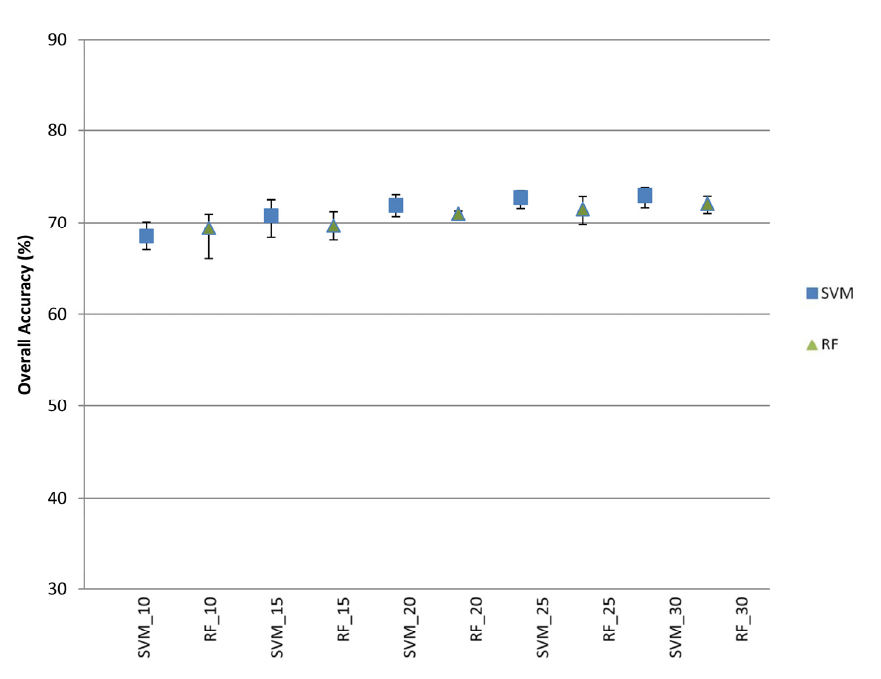
Figure 4. Overall accuracies of random forest (RF) and the Support Vector Machine (SVM) classifiers using original bands and different number of random training pixels ( N = 10; 15; 20; 25 or 30) from each vegetation class (mean ± SD).